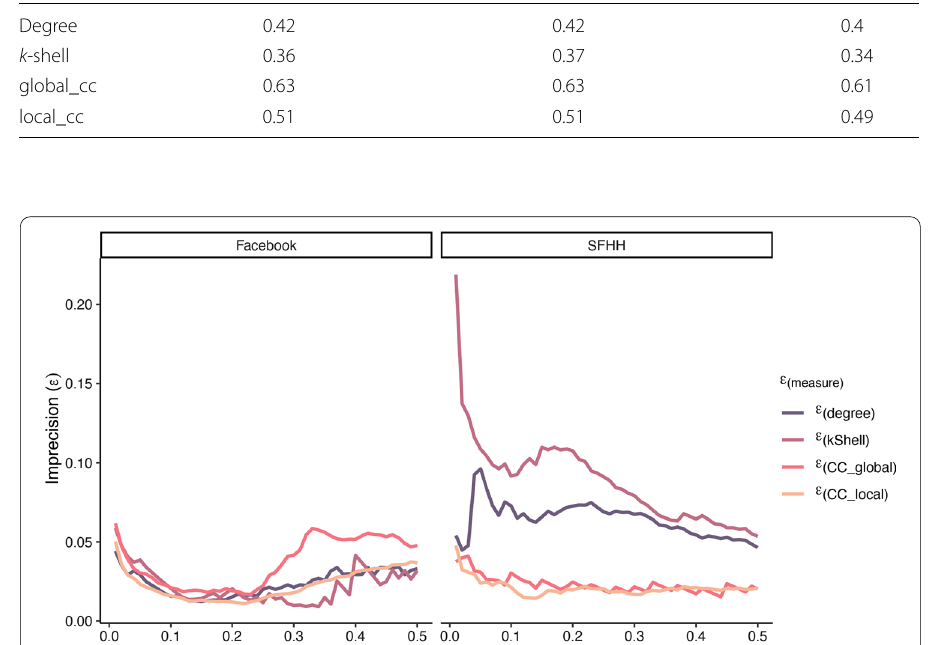
Fig. 3 Imprecision of identifying the top p fraction of spreaders by different measures over growing p